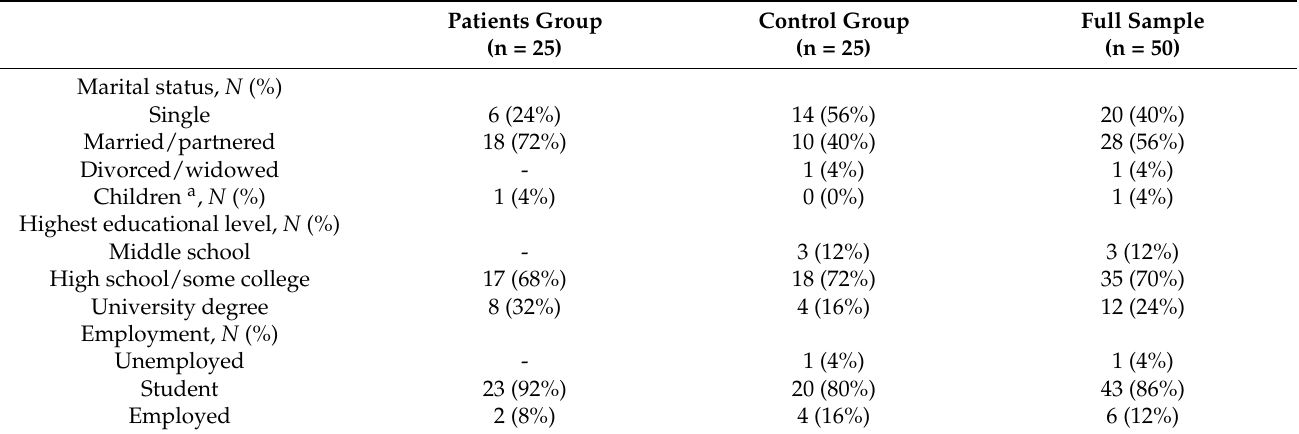
Table 1. Sociodemographic characteristics of participants.